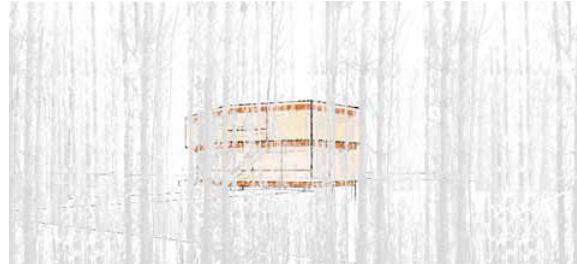
fig. 6. rough Grounds, octagon House, Gloucestershire, uK, Pierre D´avoine architects, 2006. © Pierre D´avoine architects. Note: representation, by isolating some of the multiple factors present in a work of architecture, directs our attention to one or more of them. In this case, the architect may intend to highlight the perceptual dissolution of a house which is surrounded by a forest.